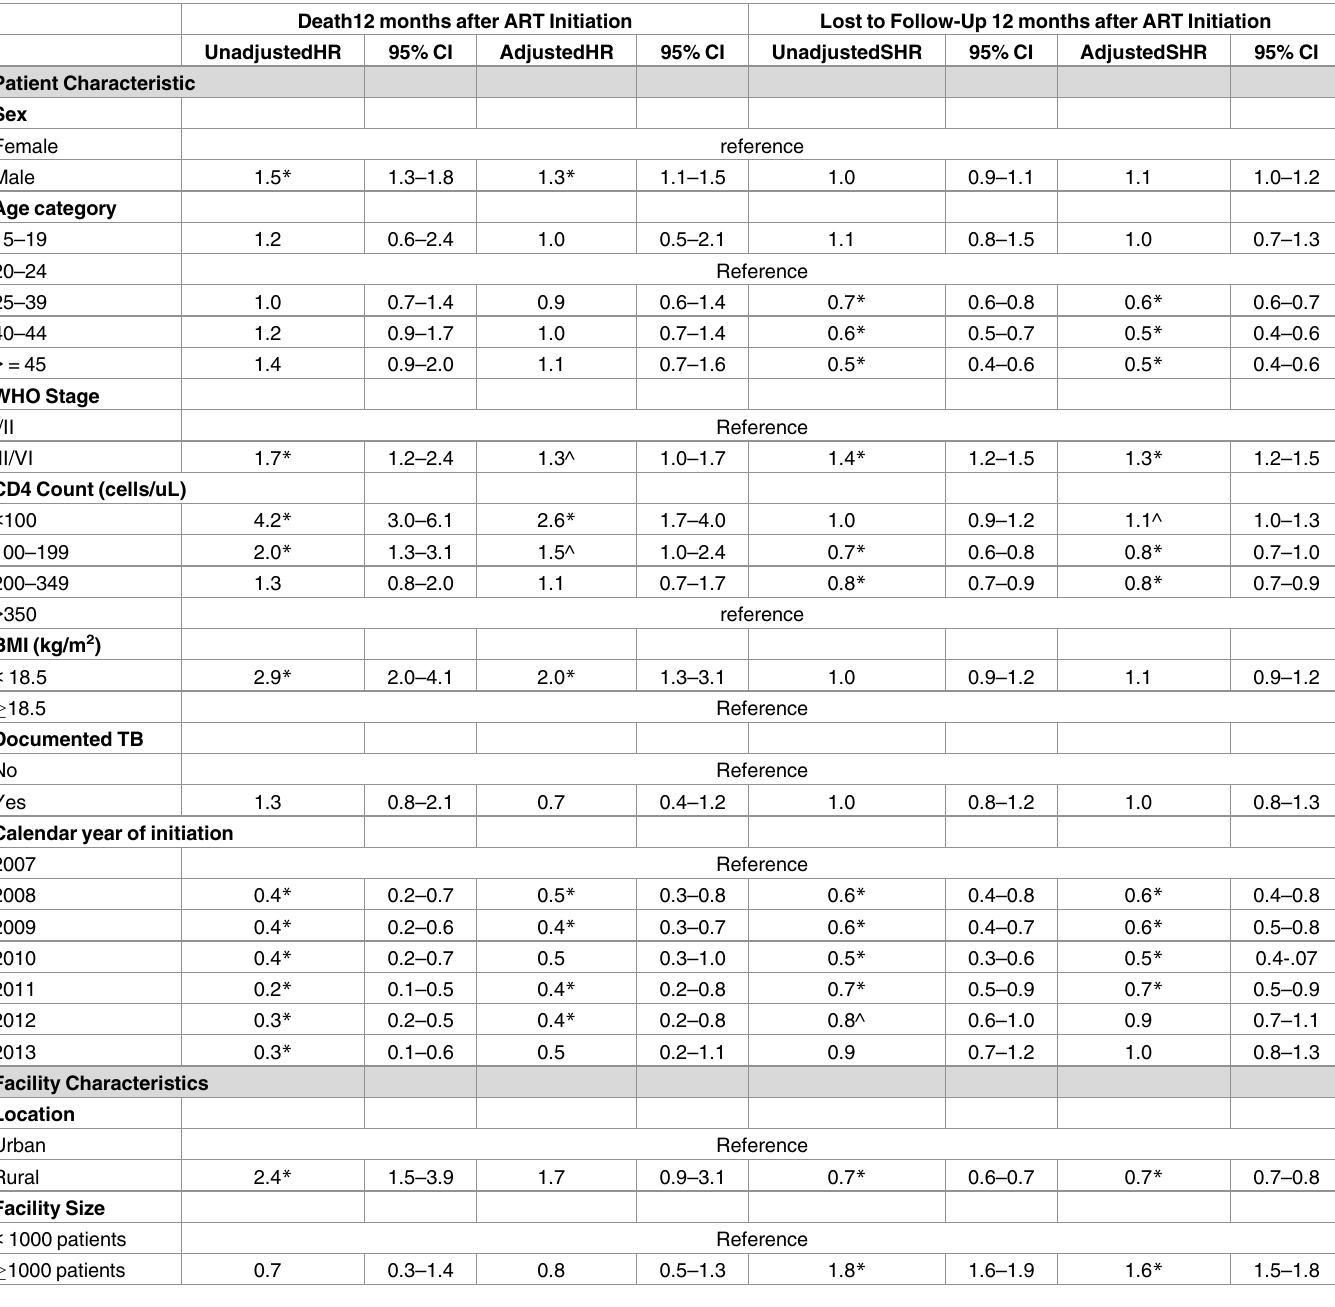
Table 3. Patient and facility characteristics associatedwith death and lost to follow-up at 12 months after antiretroviral